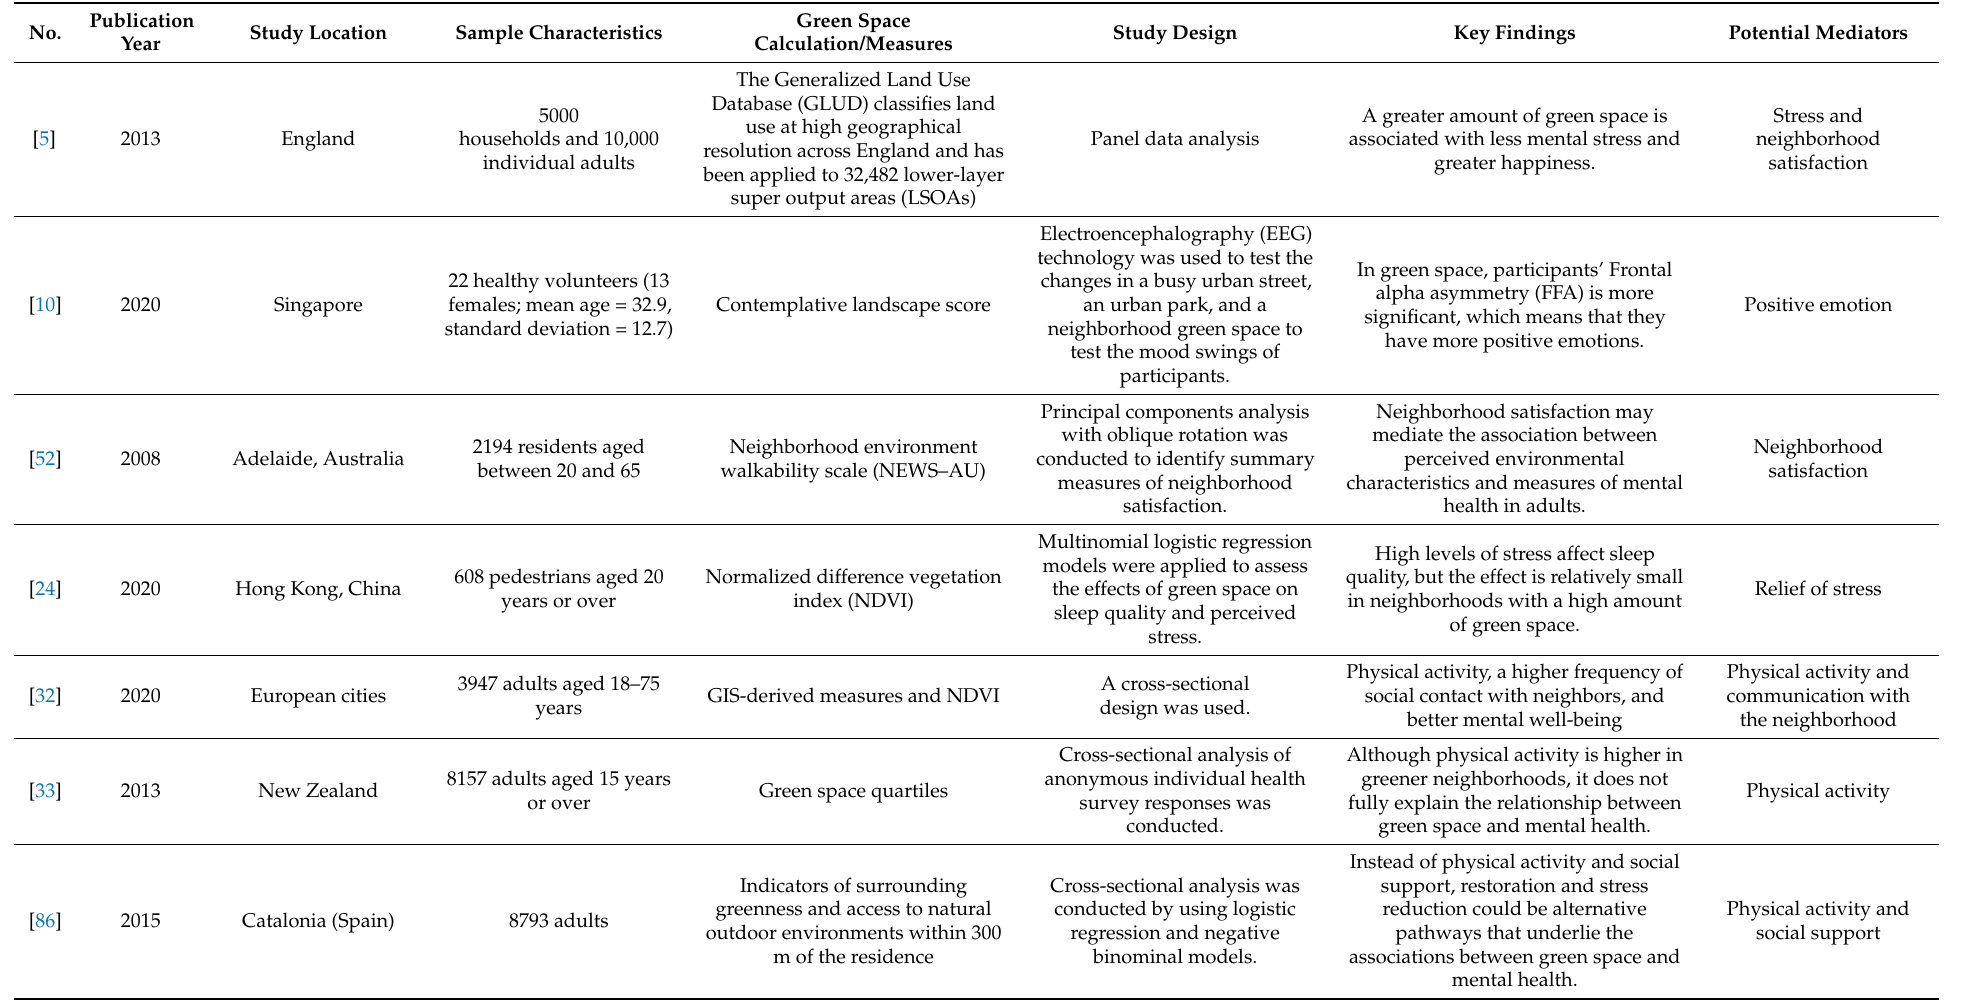
Table A1. Main characteristics and results of the studies on green space and mental